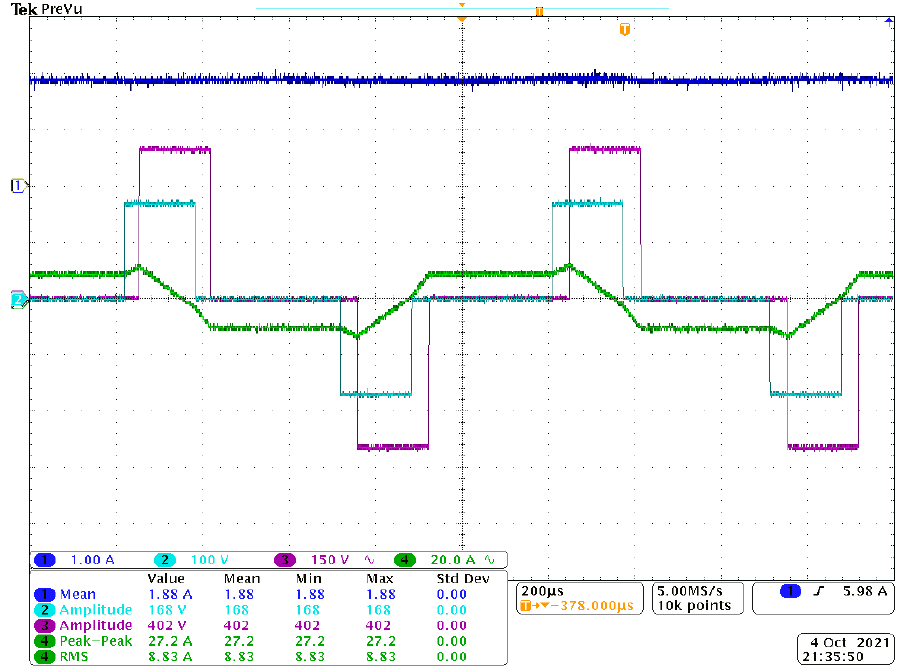
Figure 17. DAB operation at low power under the DPS